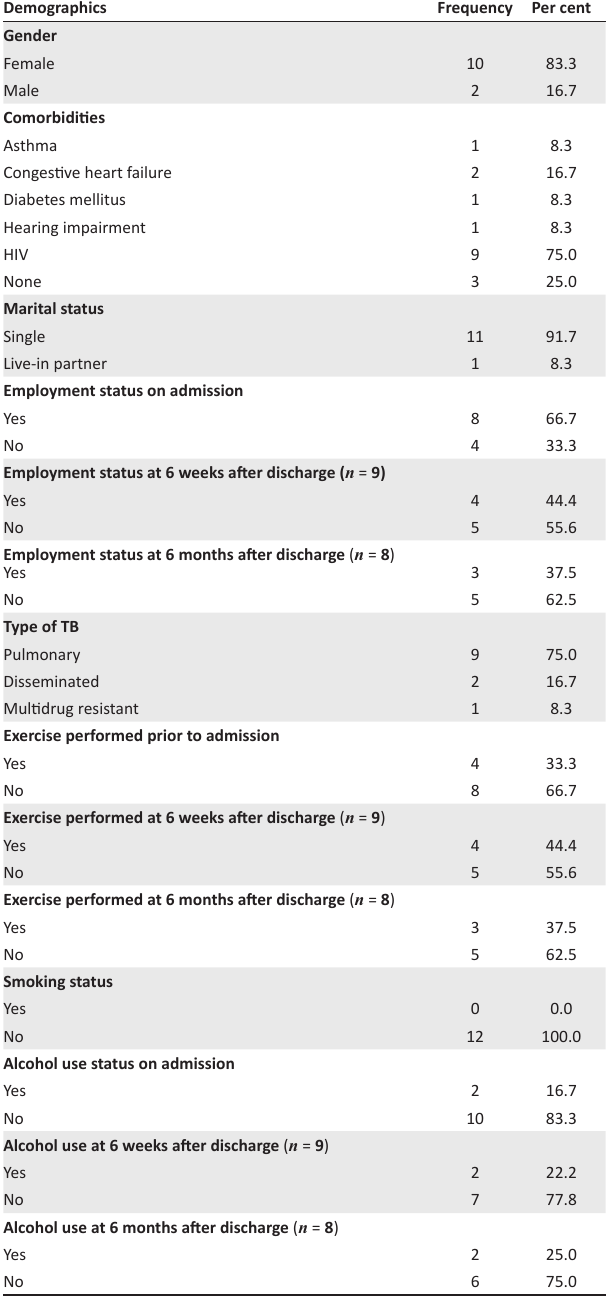
TABLE 1: Demographic information of the study cohort ( n =